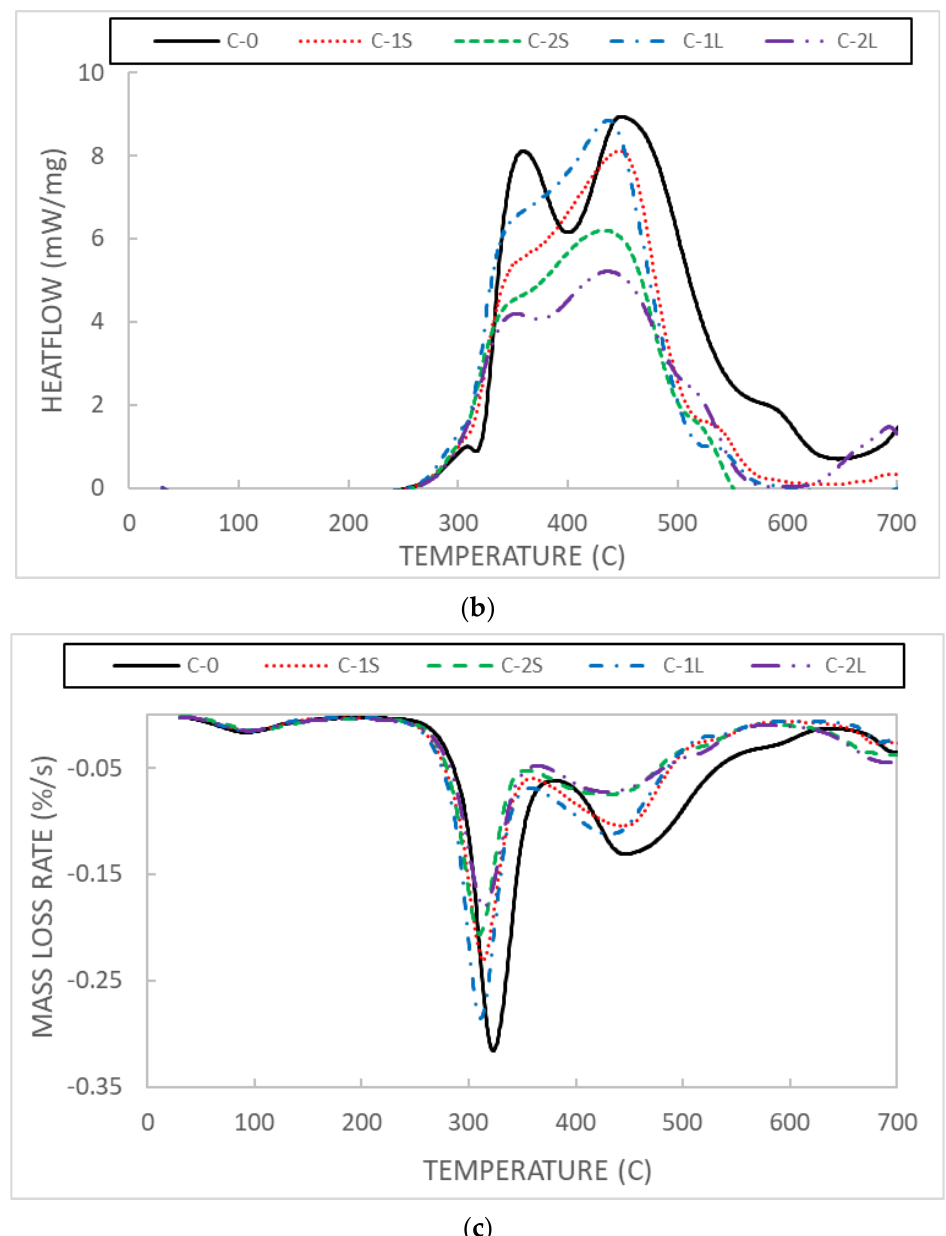
Figure 7. Thermogravimetric analysis of the samples. ( a ) TG, ( b ) DTG and ( c ) DTA.